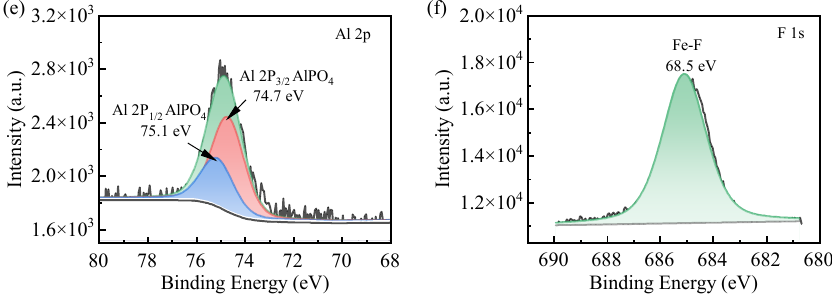
Figure 7. X-ray photoelectron spectroscopy (XPS) spectra of precipitate under optimal conditions. (agitation rate = 400 rpm, reaction time = 5 min, reaction temperature = 25 °C, and final pH value 3.77). ( a ) P 2p; ( b ) Fe 2p; ( c ) Li 1s; ( d ) O 1s; ( e ) Al 2p; ( f ) F 1s.